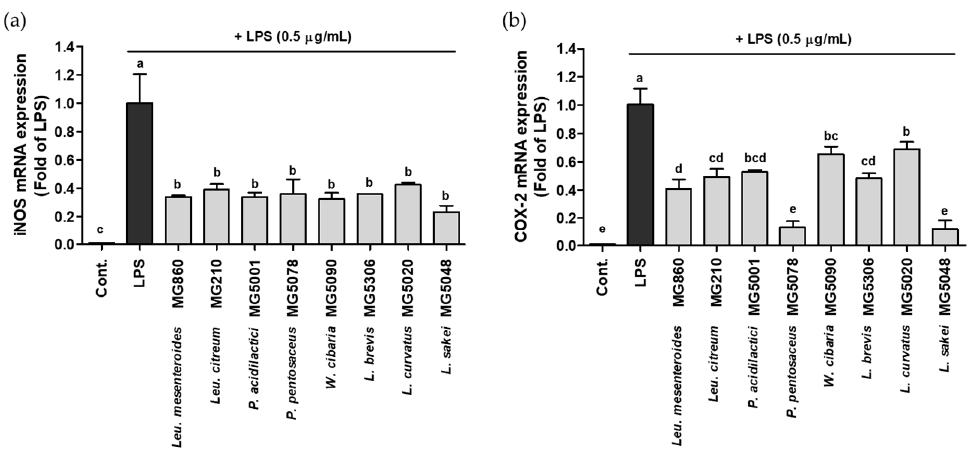
Figure 2. Effect of CFS from LAB strains on gene expression of ( a ) iNOS and ( b ) COX-2 in LPS- activated RAW264.7. Data are represented as mean ± SD and bar with different letters indicating significance at p < 0.05.